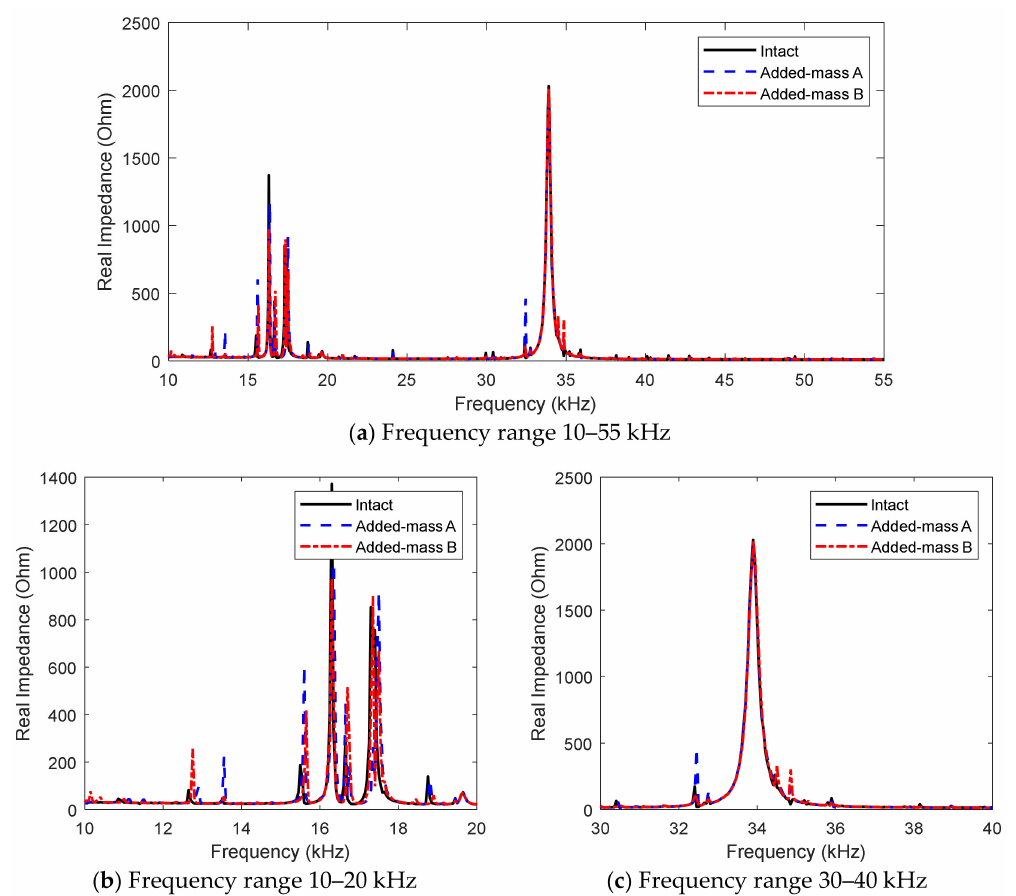
Figure 11. Experimental impedance signatures of PZT interface for intact and damage cases of connection splice plate.